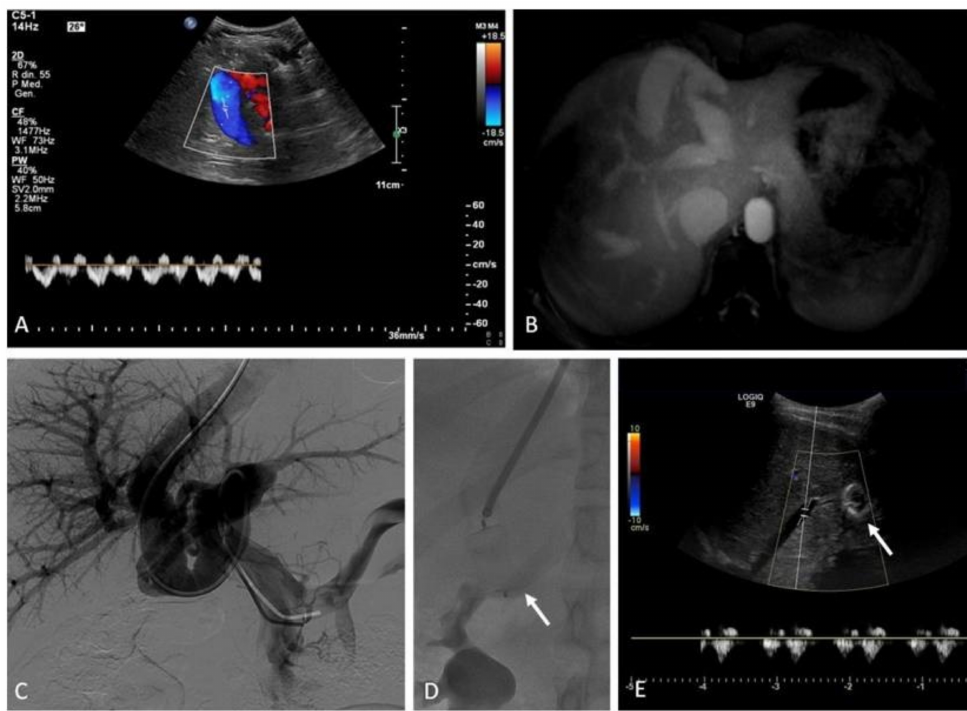
Figure 10. Transcatheter plug occlusion of a congenital intrahepatic porto-systemic shunt in a 17-year-old female. ( A ) CDUS image shows an enlarged middle hepatic vein aberrantly communicat- ing with the left portal vein branch. ( B ) Magnetic Resonance Angiography image offers a panoramic view of the aberrant porto-systemic shunt, useful to plan the percutaneous occlusion procedure. ( C ) Transjugular portal vein venography was performed through retrograde catheterization of the shunt. ( D ) Fluoroscopic image shows the deployment of a 24-mm vascular plug (arrow) within the shunt. ( E ) B-mode US image shows size normalization of the middle hepatic vein after effective shunt occlusion with the plug (arrow). The patient healed from post-prandial